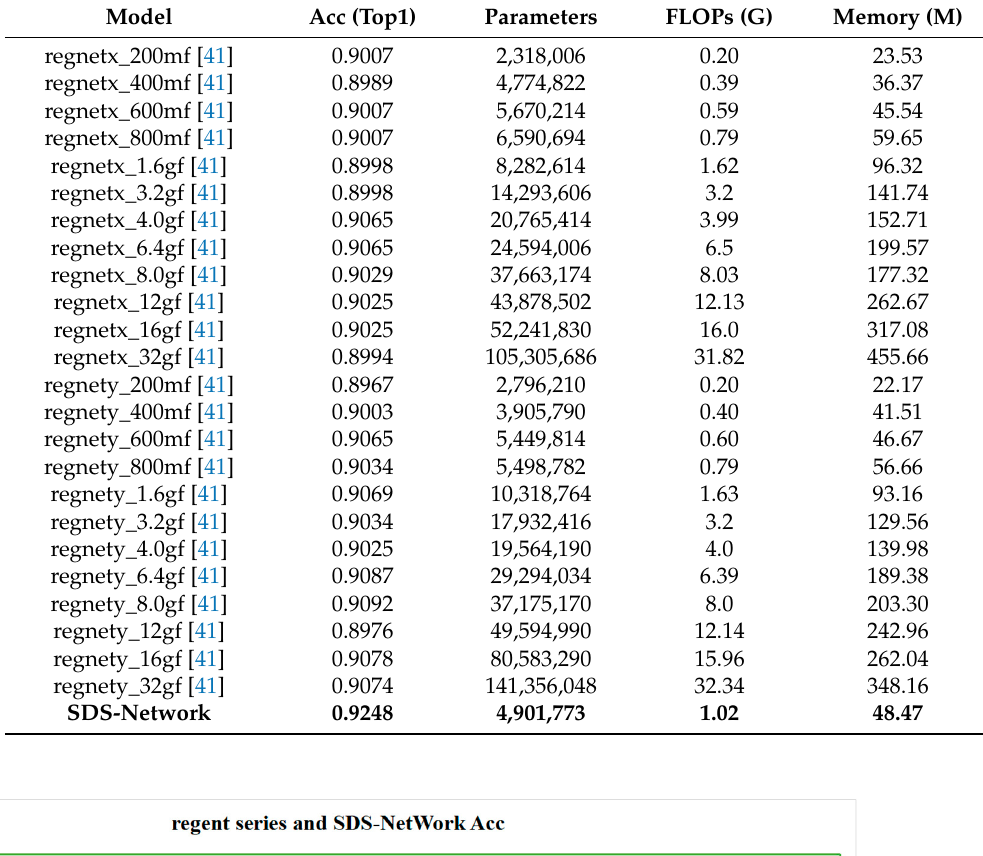
Table 7. Comparison of SDS-Network model and regnet series of algorithms.